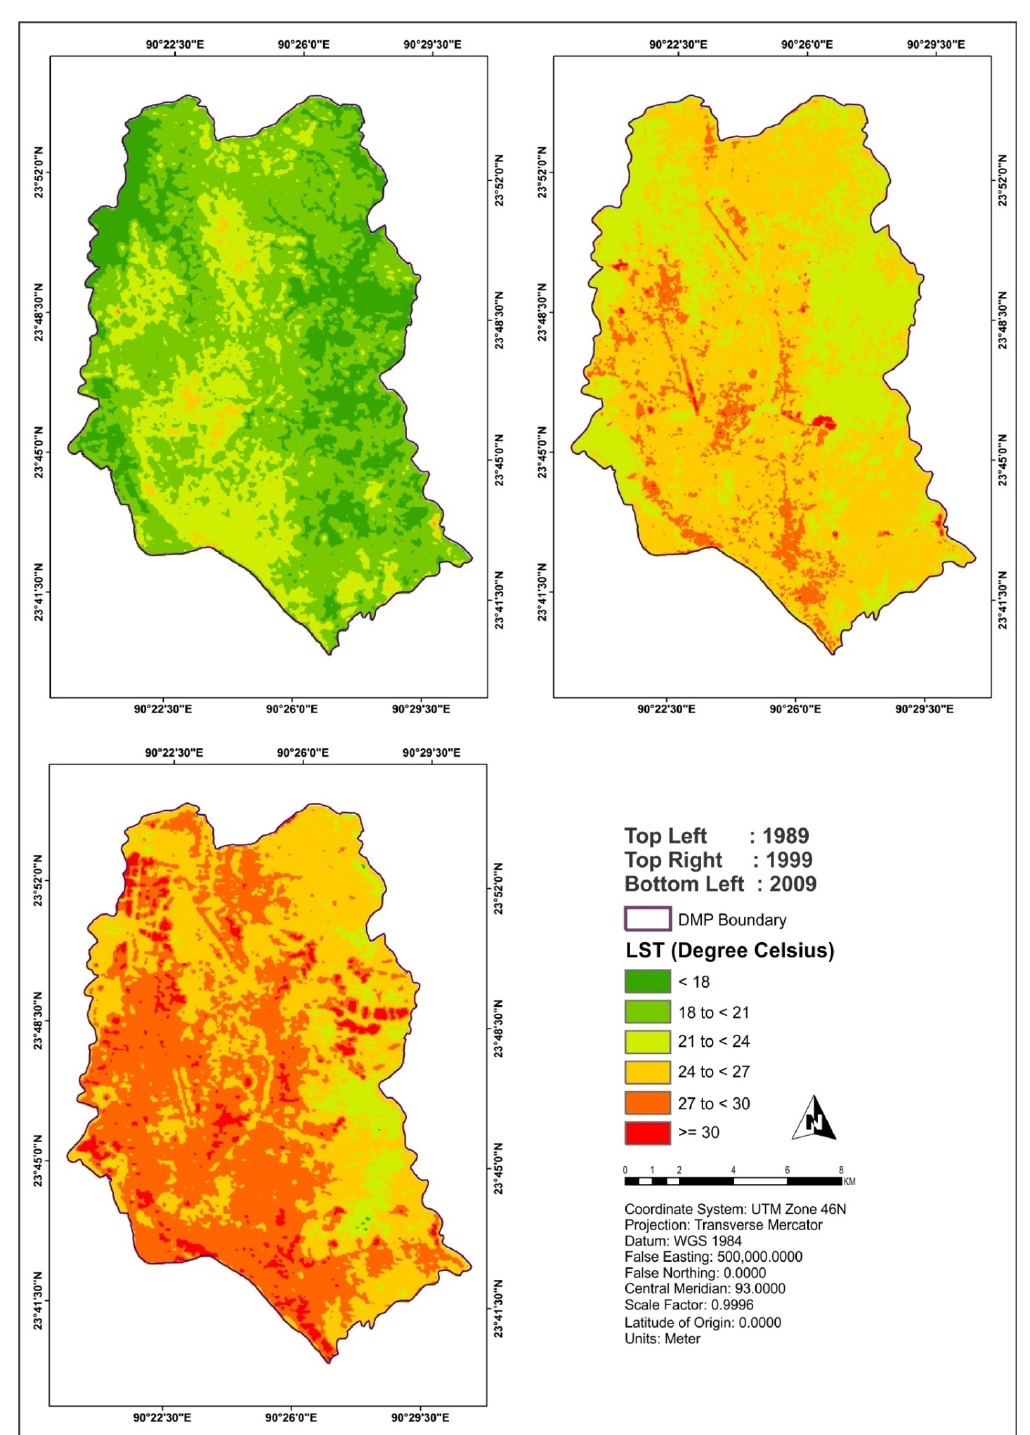
Figure 4. Spatial distribution of land surface temperature